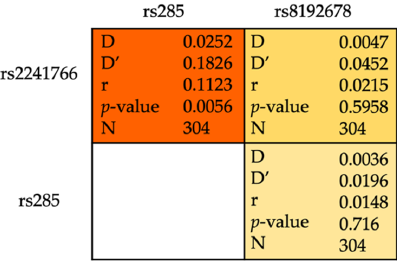
Table 4. Genotype frequencies of polymorphisms associated with MetS.